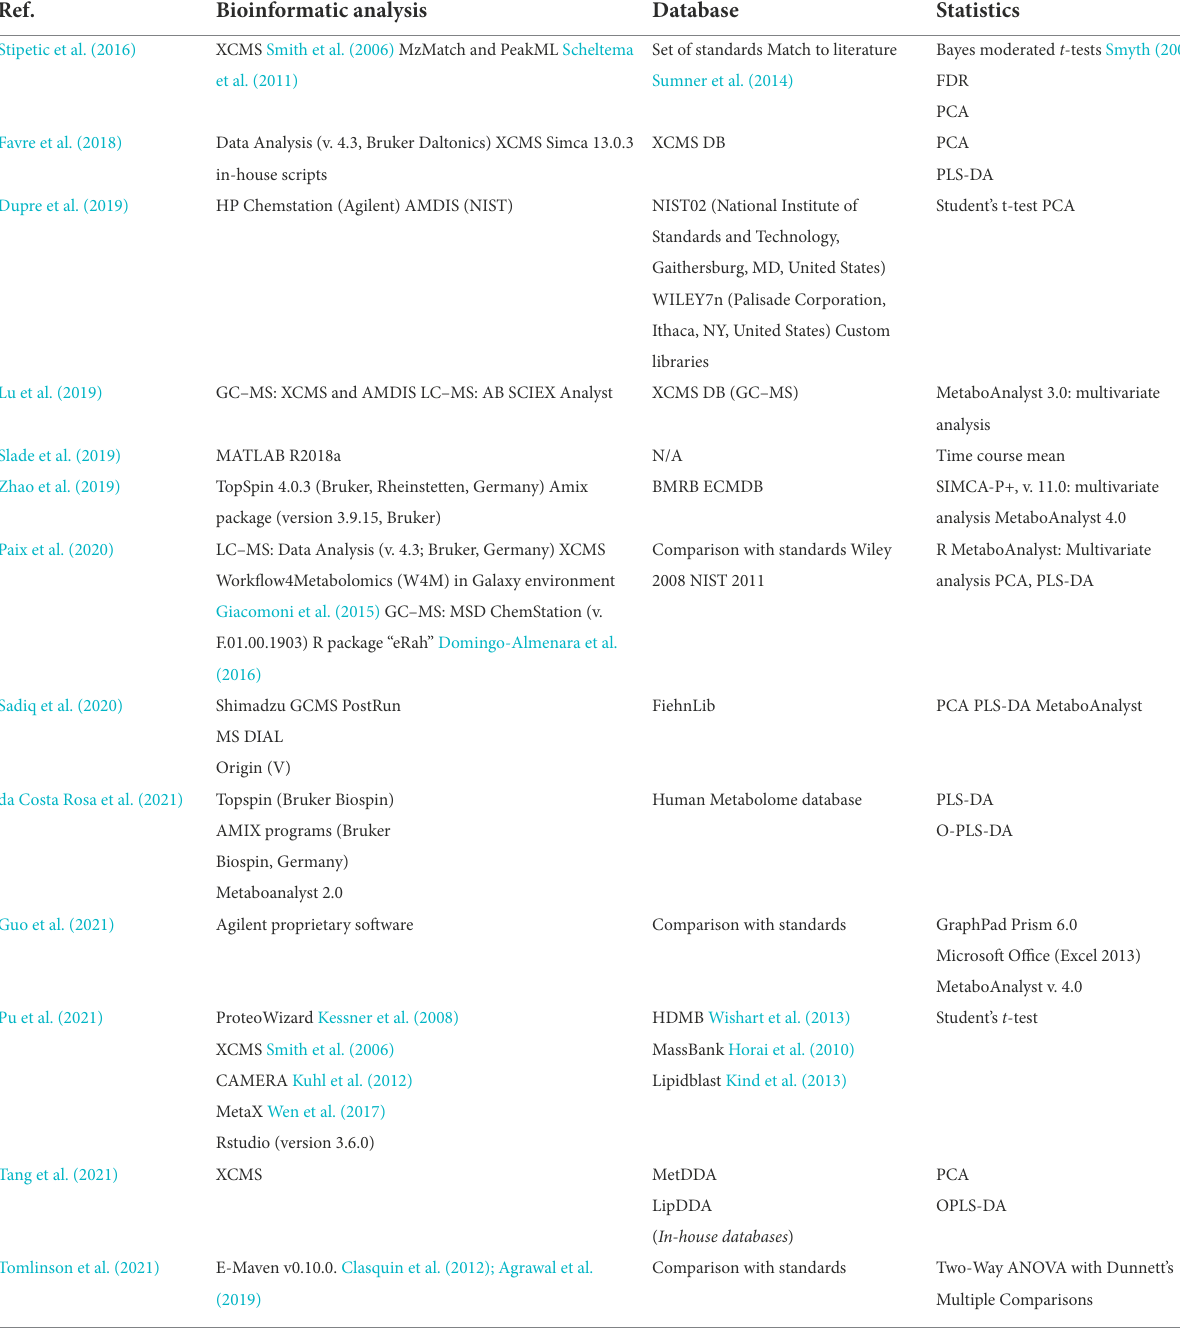
TABLE 1 Computational approaches used in cell-surface interaction research studies.